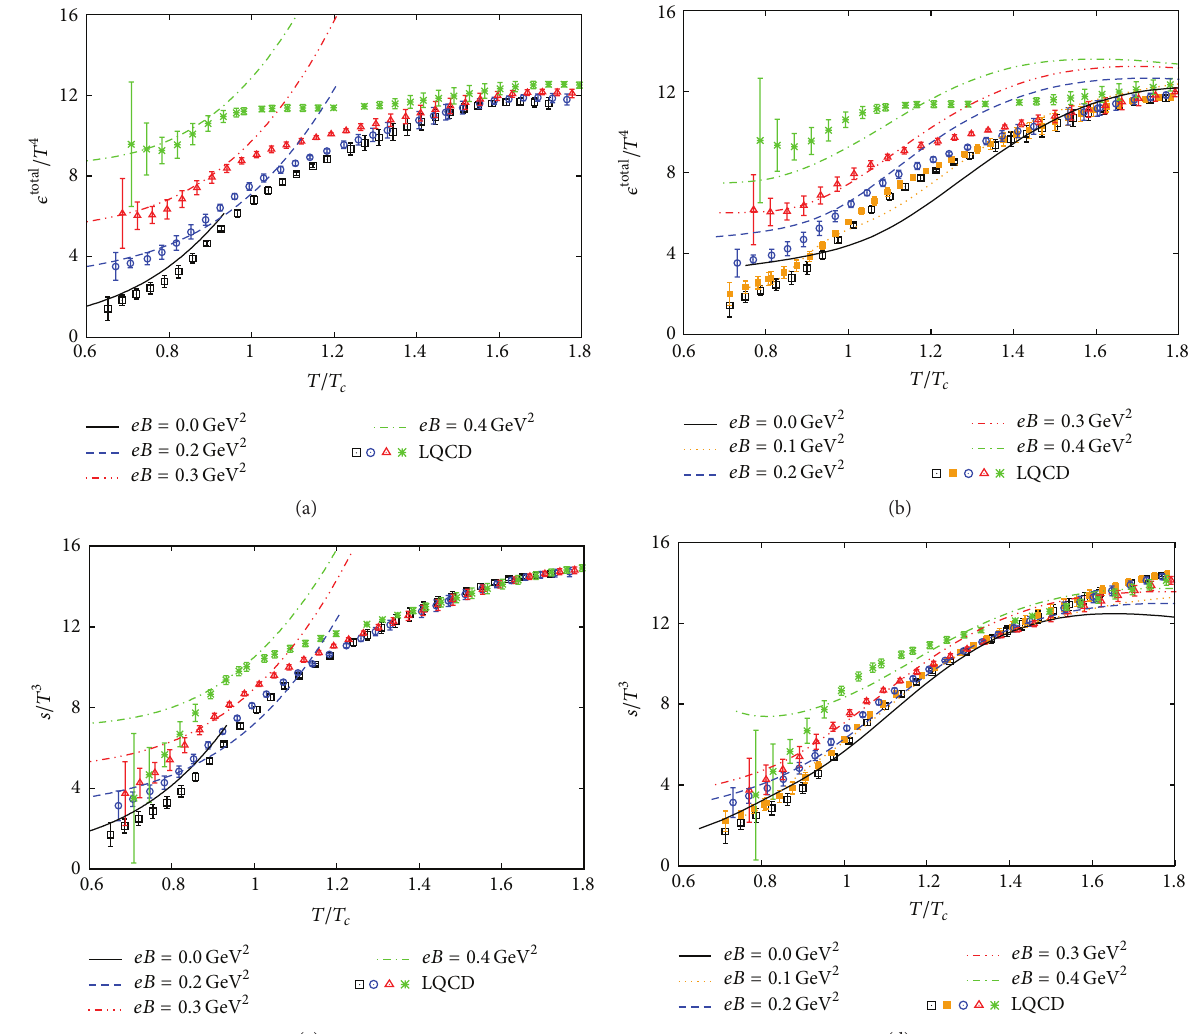
Figure 3: The same as in Figure 1 but for normalized total energy density (21) in (a, b) and normalized entropy density in (c, d).